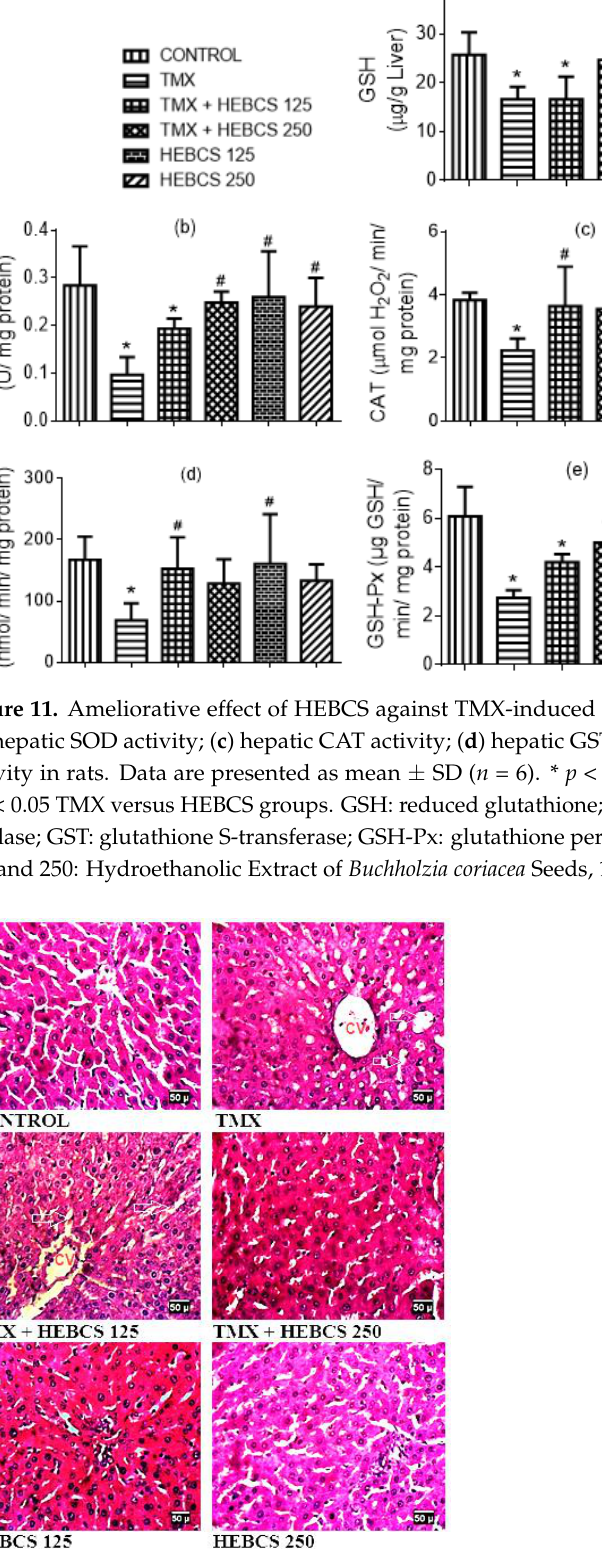
Figure 13. Representative images (×400) of Oil red O stained liver sections. TMX: Tamoxifen; HEBCS 125, 250: Hydroethanolic Extract of Buchholzia coriacea Seeds, 125 and 250 mg/kg body weight.